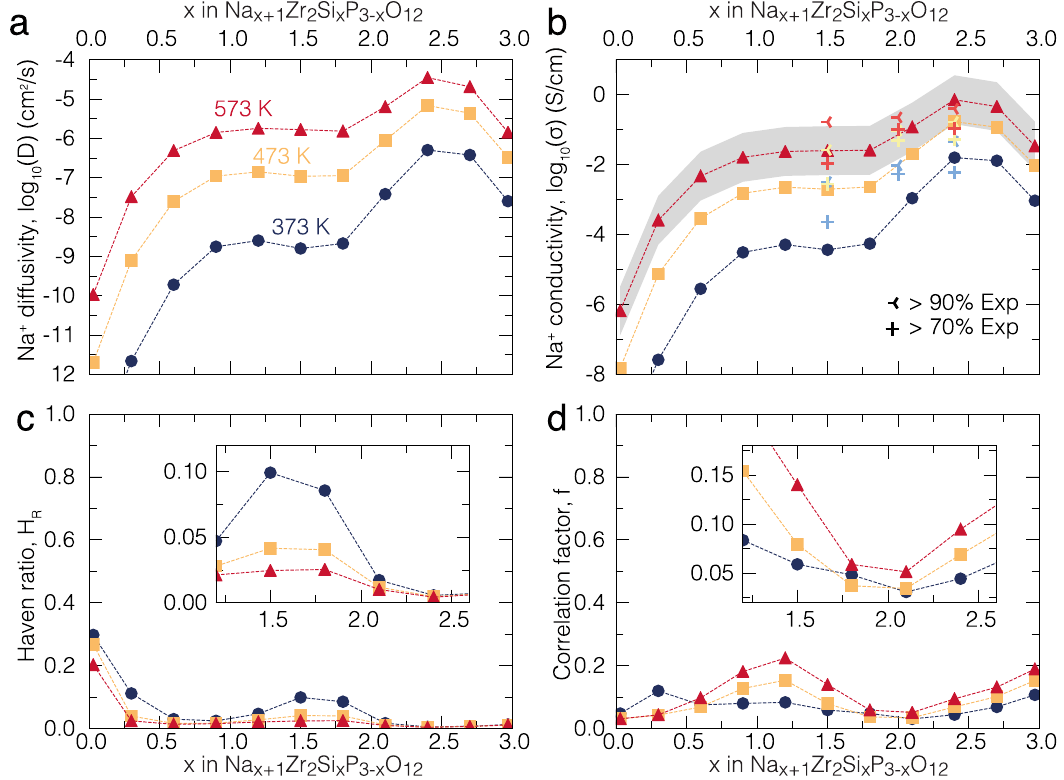
Fig. 2|ComputedNa-iontransportpropertiesofNa 1+ x Zr 2 Si x P 3 − x O 12 bulkbased on kinetic Monte Carlo simulations. Calculated Na + diffusivity ( a ), conductivity ( b ), Haven ’ s ratio ( c ) and averaged correlation factor ( d ) of Na 1+ x Zr 2 Si x P 3 − x O 12 at several temperatures: 373 (dark blue circles), 473 (orange squares) and 573 (red triangles) K, respectively. In panel ( b ), the computed ionic conductivities are compared with the experimental values of this work (Supplementary Fig. 6) at selectedtemperatures.Experimentalvaluesin( b )fromthisworkaredepictedwith